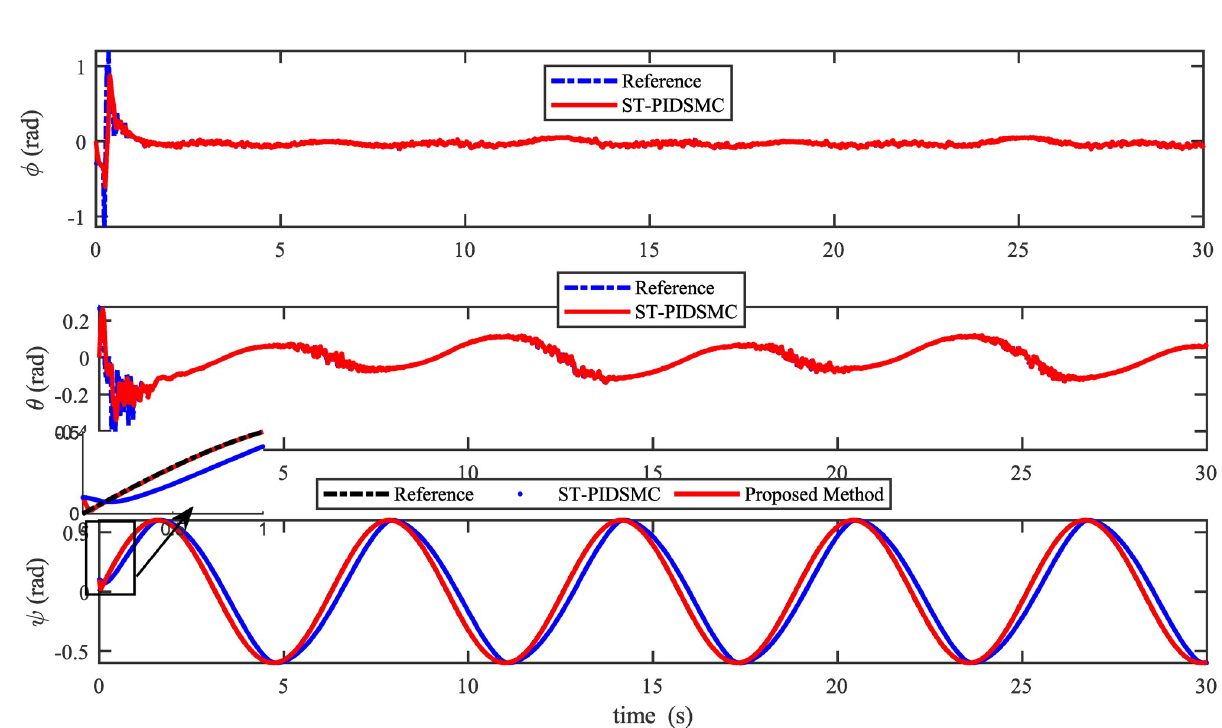
Fig 15. Results of the attitude under the proposed and ST-PID-SM controllers.